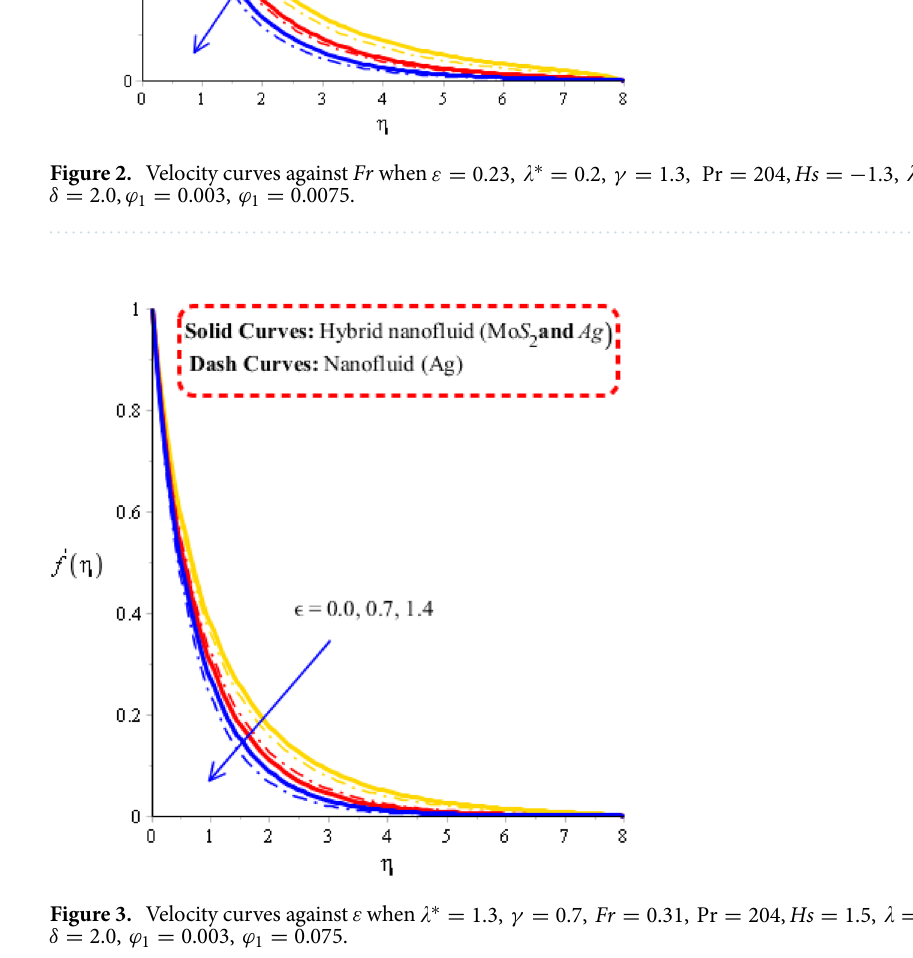
Figure 3. Velocity curves against ε when (cid:31) ∗ δ = 2.0, ϕ 1 = 0.003, ϕ 1 =